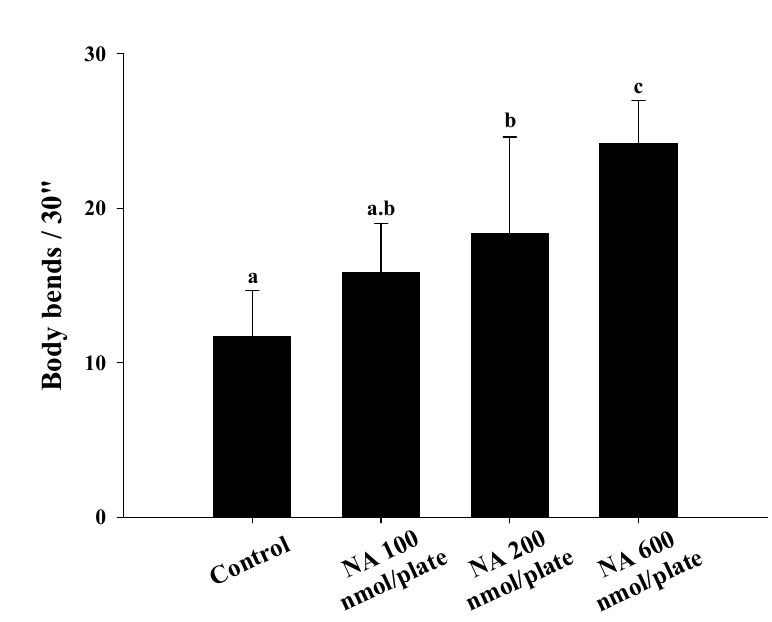
Figure 3. Effects of nicotinic acid (NA) on the lifespan of C. elegans and accessory aging markers, including pharyngeal pumping, autofluorescence, and body bends. Nematodes were grown on plates containing various dosages of NA as described in Section 4. ( a ) 90 worms ( n = 90) for each group were used, counting the number of surviving worms every two days to obtain the lifespan data. ( b ) On the third, fifth, and seventh days of life, the pharyngeal pumping of nematodes ( n = 10 worms) was determined. ( c ) On the 10th day of life, the red autofluorescence of the nematodes ( n = 3 worms) was determined; representative images and the corresponding quantification results are shown. ( d ) On the 11th day of life, body bend of the nematodes ( n = 10 worms) was determined. Values (mean ± SD) not sharing a common letter are significantly different ( p < 0.05). Scale bar is 100 μ m.